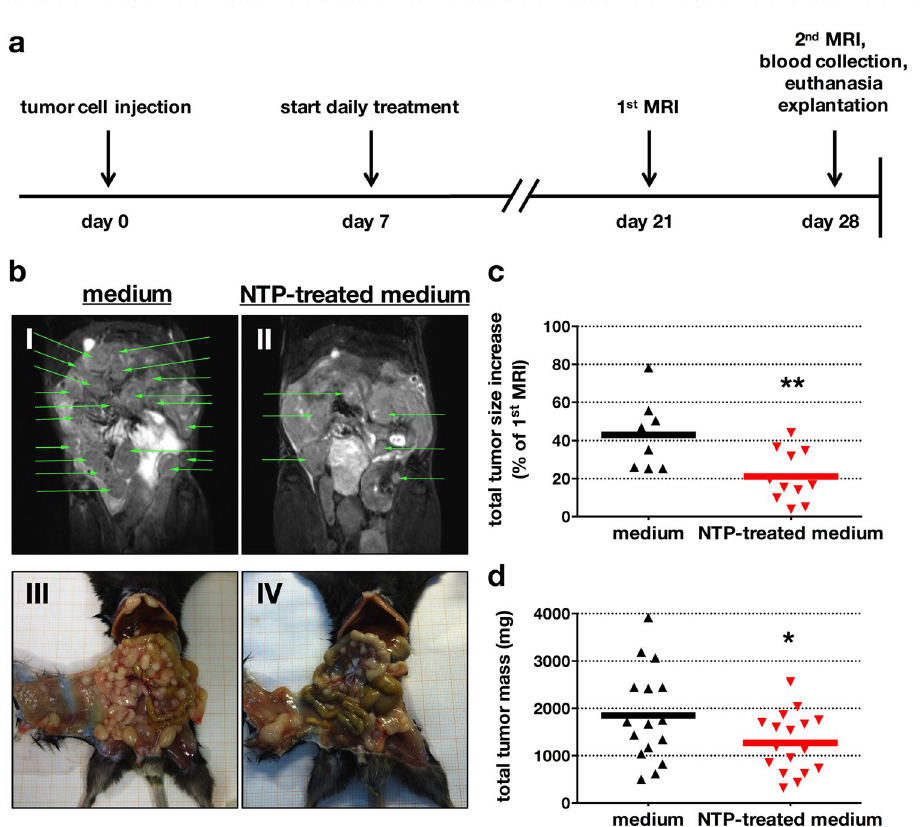
Figure 3. NTP-treated medium decreased number, growth, and size of pancreatic lesions in vivo . The experimental timeline ( a ) is given. The number of tumor nodes in the peritoneum was followed by MRI and was elevated in the control animals (I) compared to NTP-treatment group (II) at the end of treatment (d28). Also, corresponding macroscopic findings for control (III) and NTP-treated (IV) animals are shown ( b ). MRI-based calculation of tumor volume revealed a significantly decreased total tumor growth in the treatment group ( c ). At day 28, animals were sacrificed and tumor nodes were excised and weighed, showing a significantly decreased total tumor mass ( d ). Representative images of 13 animals are given, green arrows indicate tumor nodes (one green arrow per lesion) ( b ). Data are presented as mean of 8–17 animals ( c , d